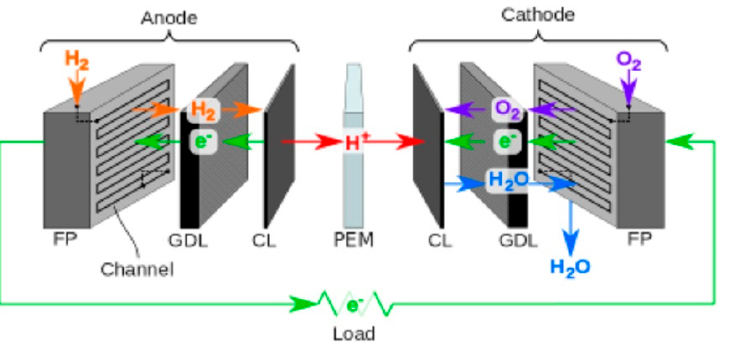
Figure 1. Construction and principle of hydrogen proton-exchange membrane fuel cell (PEMFC) [10,11]. Fuel cells use direct conversion of chemical energy into electric power, and that is the reason for their high efficiency and almost no emissions. The main type of FC emission is a thermal emission that occurs during FCs operation, especially at high loads. The FC voltage as a function of current density can be seen in Figure 2 below, where OCV is the open-circuit voltage. The value of 1.2 V represents a theoretically loss-free voltage. The actual cell voltage, including the off-load voltage, is always lower than this value.